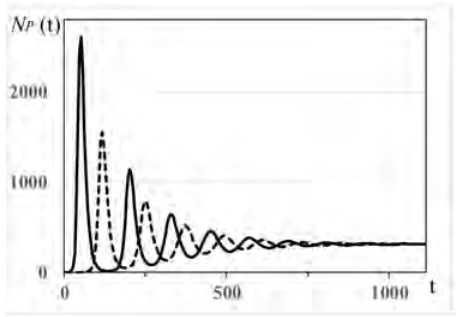
Fig. 15. of N P ( t ) for oscillating dynamics for 2 different initial values ϕ ( a ) .